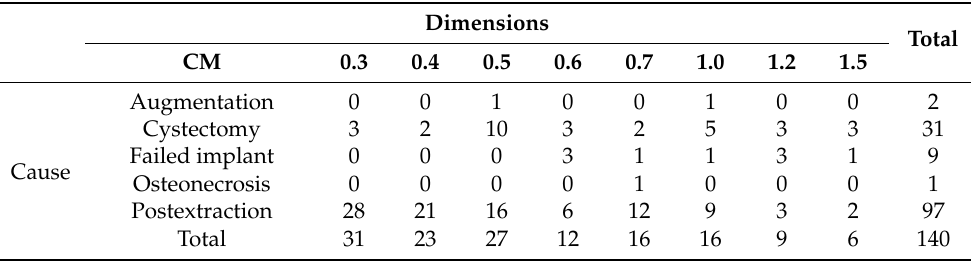
Table 1. Main causes: during bone graft placement (augmentation), cystectomy, implant placement, postexodontia (post extraction); dimensions: from 0.3 cm to 1.5 cm.